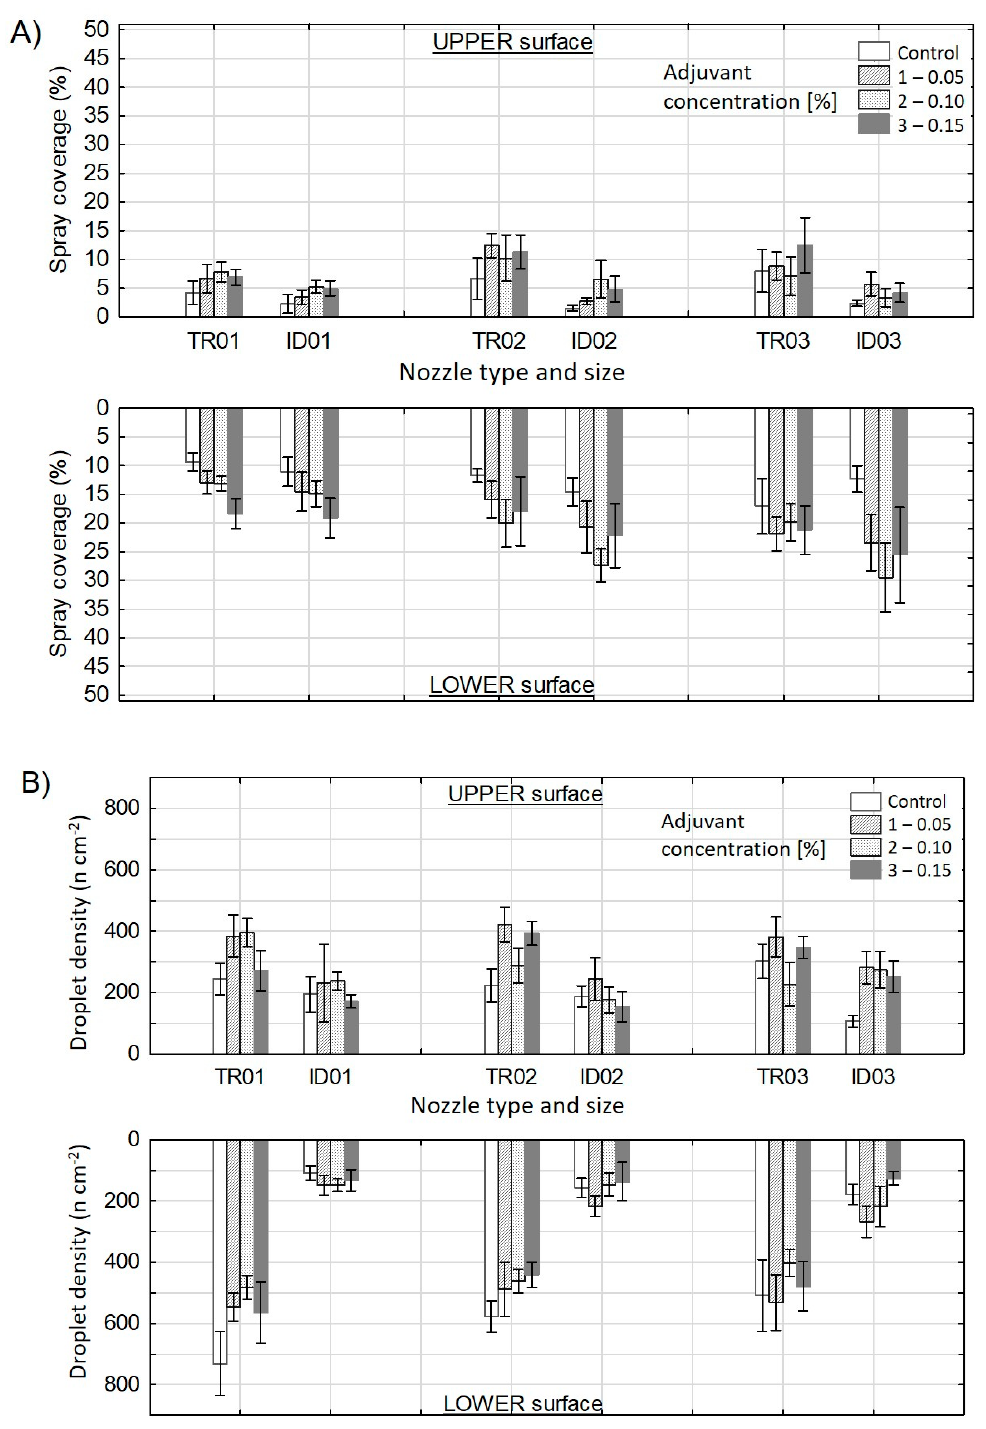
Figure 3. Effects of Silwet L-77 adjuvant concentration and nozzle type and size (TR—fine spray hollow cone nozzles; ID coarse spray flat fan air-inclusion nozzles); nozzle sizes 01, 02, 03 acc. to ISO 10625:2018 on: ( A ) spray coverage on the upper and lower leaf surface (%) (mean); ( B ) droplet density on the upper and lower leaf surface (n cm − 2 ) (mean).